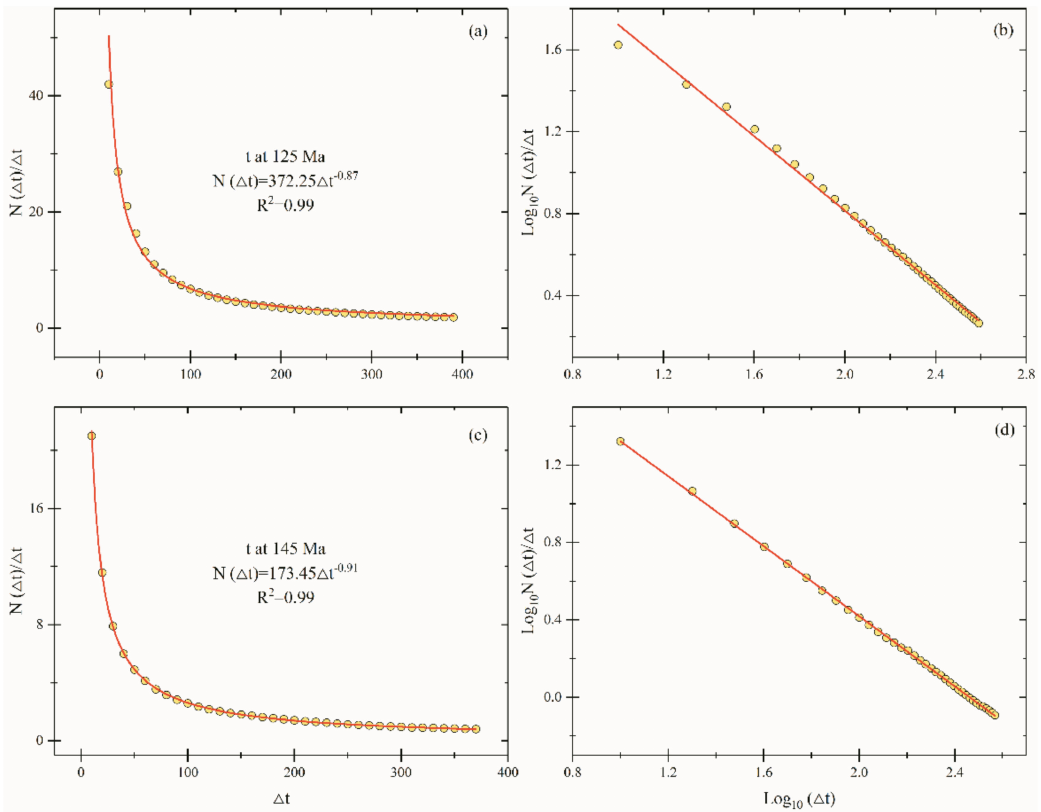
Figure 3. The results of singularity analysis of volcanic zircon U–Pb ages. Graphs ( a ) and ( b ) show the average density at 125 Ma while ( c ) and ( d ) show the average density at 145 Ma. The yellow circles stand for fractal density at every interval, and the red lines are fitted by the power-law functions. Graphs on the left side are plotted on an ordinary scale, and graphs on the right side are plotted on a log–log